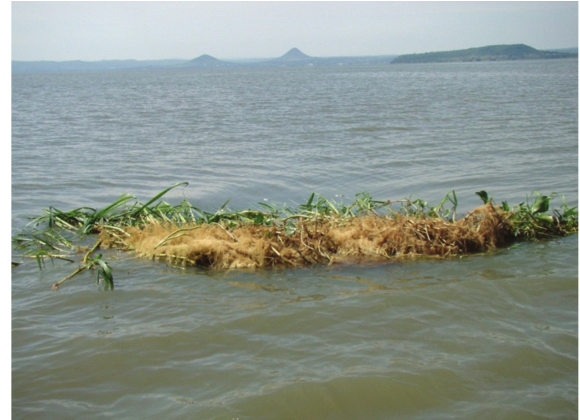
Figure 6: The sinking mats of hippograss after collapse of the water hyacinth substrate.